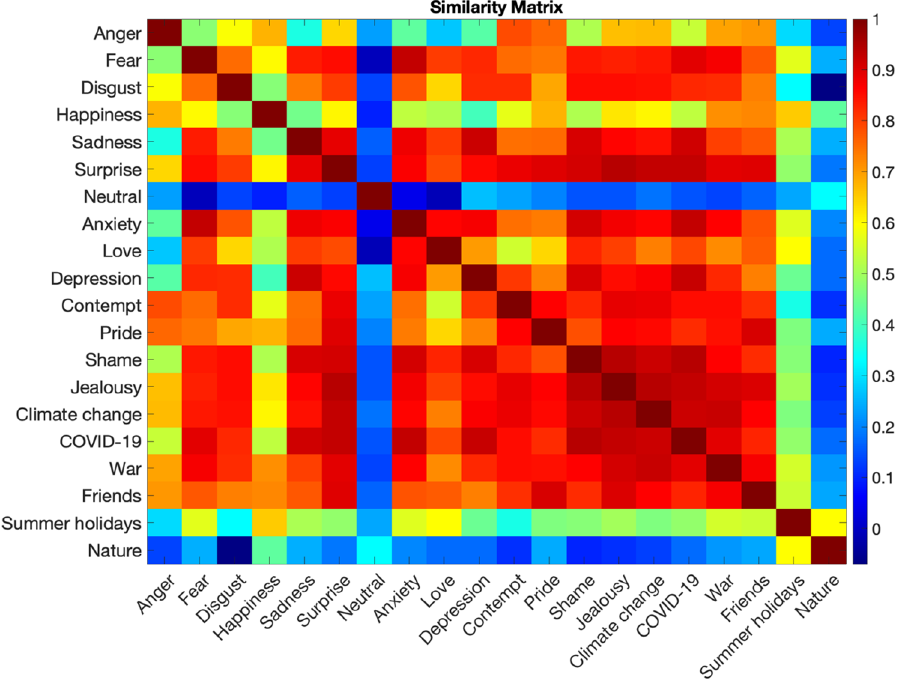
Figure 5. The similarity between each pair of emotions and phenomena (Spearman’s correlation). Each cell in the matrix represents a pairwise correlation coefficient between two body sensation maps. The colour bar indicates the r-statistic range.